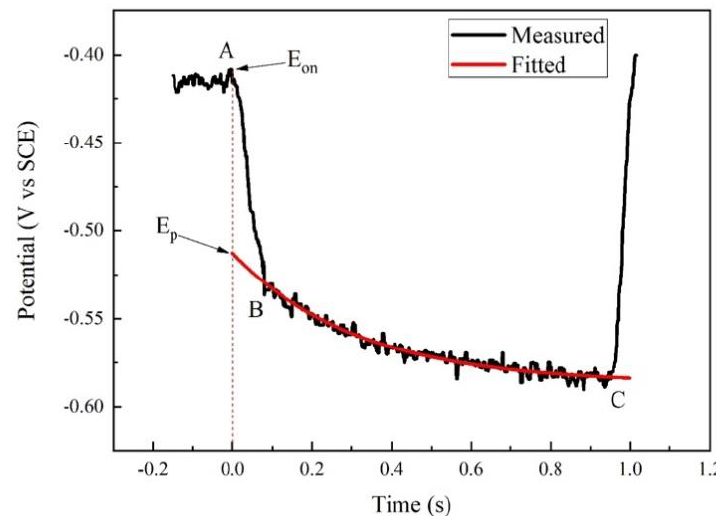
Figure 2. Transient potential – time curve during one interruption of polarization of X80 steel in 4 g·L − 1 Na 2 SO 4 solution.